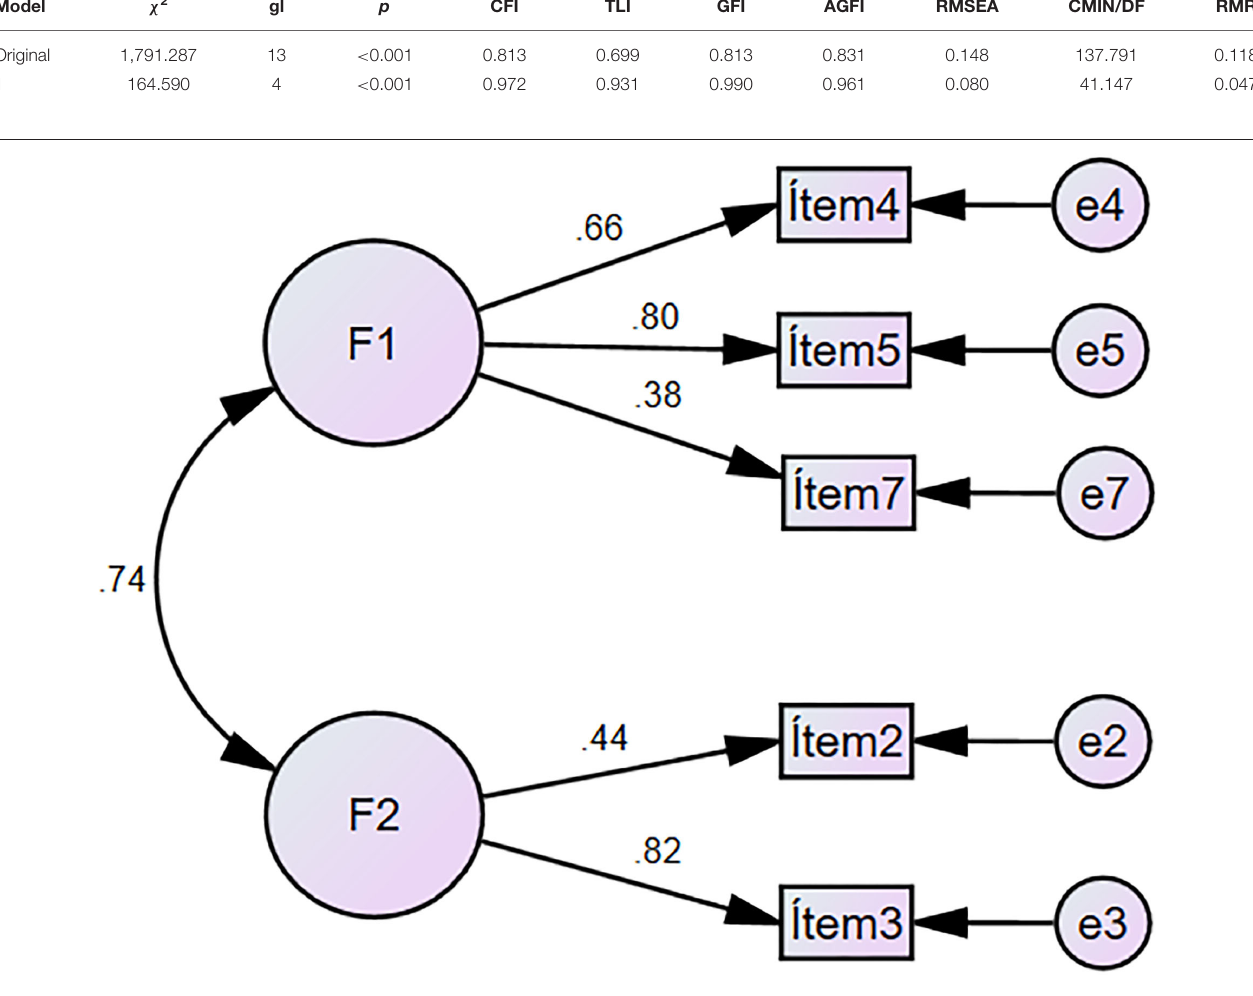
TABLE 2 | Fit indices of the factor models of the FAT-LAT-COVID-19 scale. Model